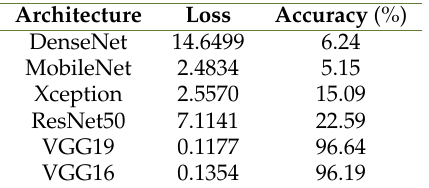
Table 2. Below given is a table with the results for the different neural network